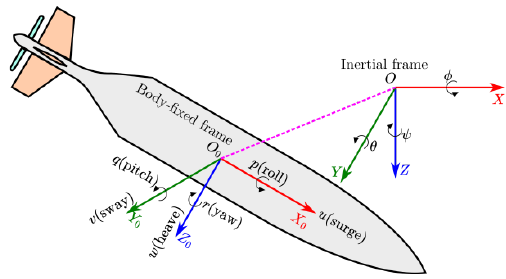
Figure 1. An AUV coordinate system.